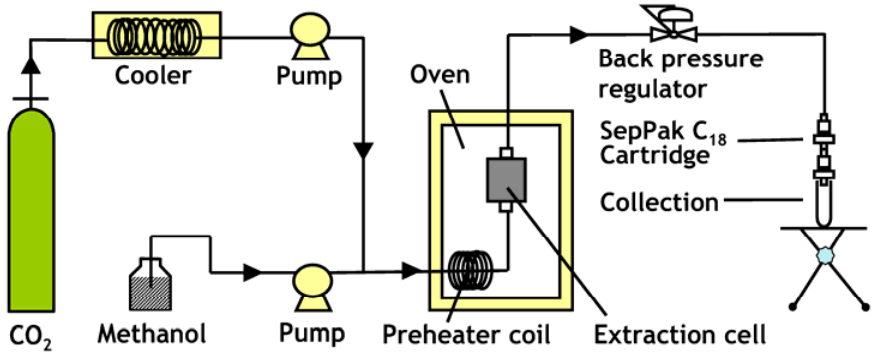
Figure 6. Schematic diagram of the supercritical carbon dioxide extraction system used in the present